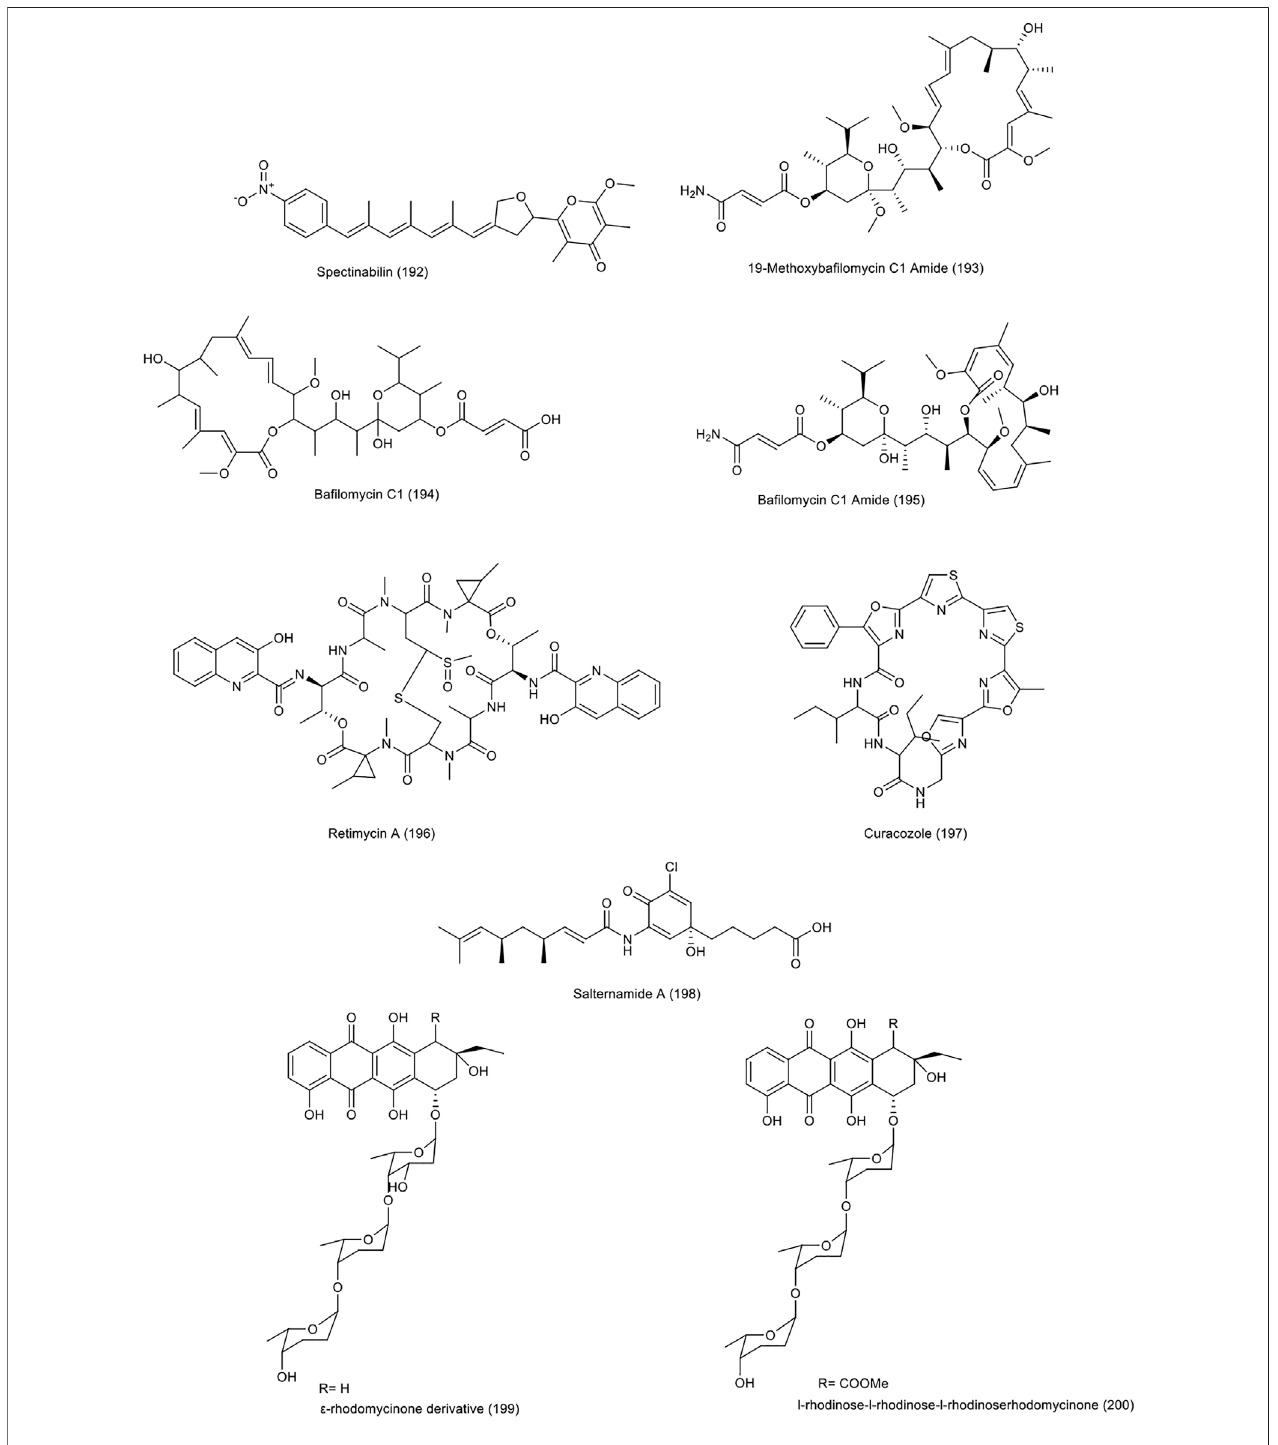
FIGURE 8 | Chemical structure of NPs produced by miscellaneous